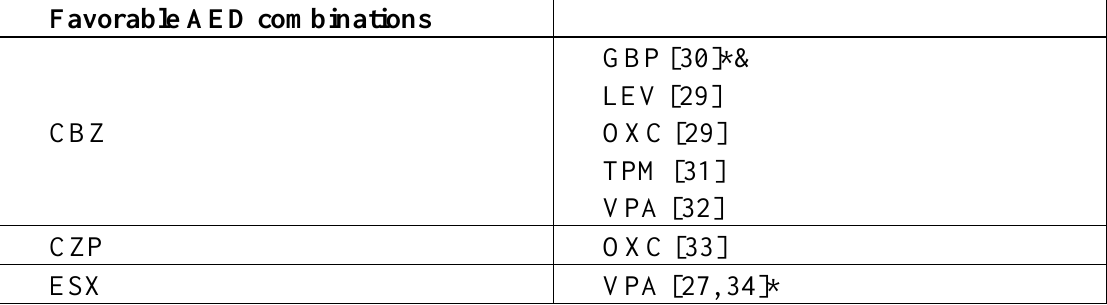
Table 2. AED combinations determined by isobolographic studies in